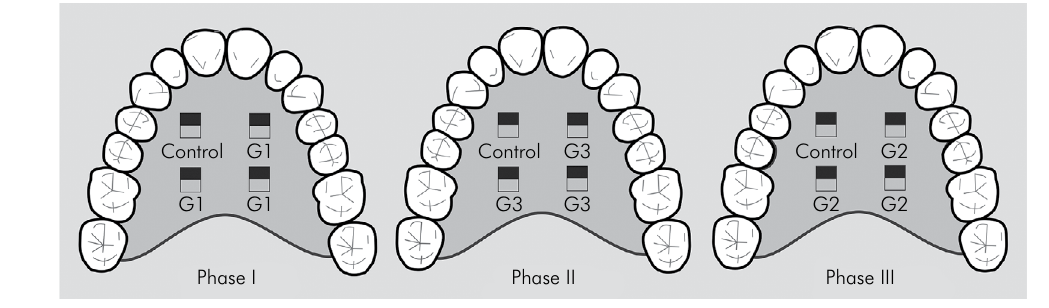
Figure 1. Schematic outline of the three phases included in the experimental design for the clinical study. Control (no treatment), 0.05% NaF, 0.1% EGCG, and Green tea. The control group was present in all